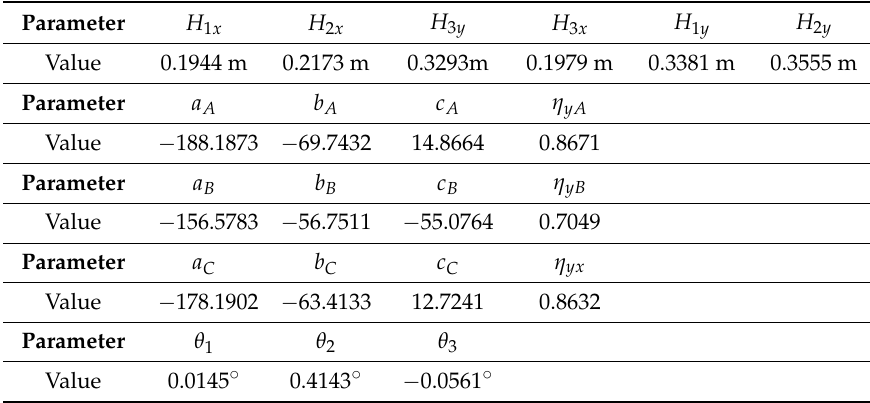
Table 7. The estimated values of parameters using model